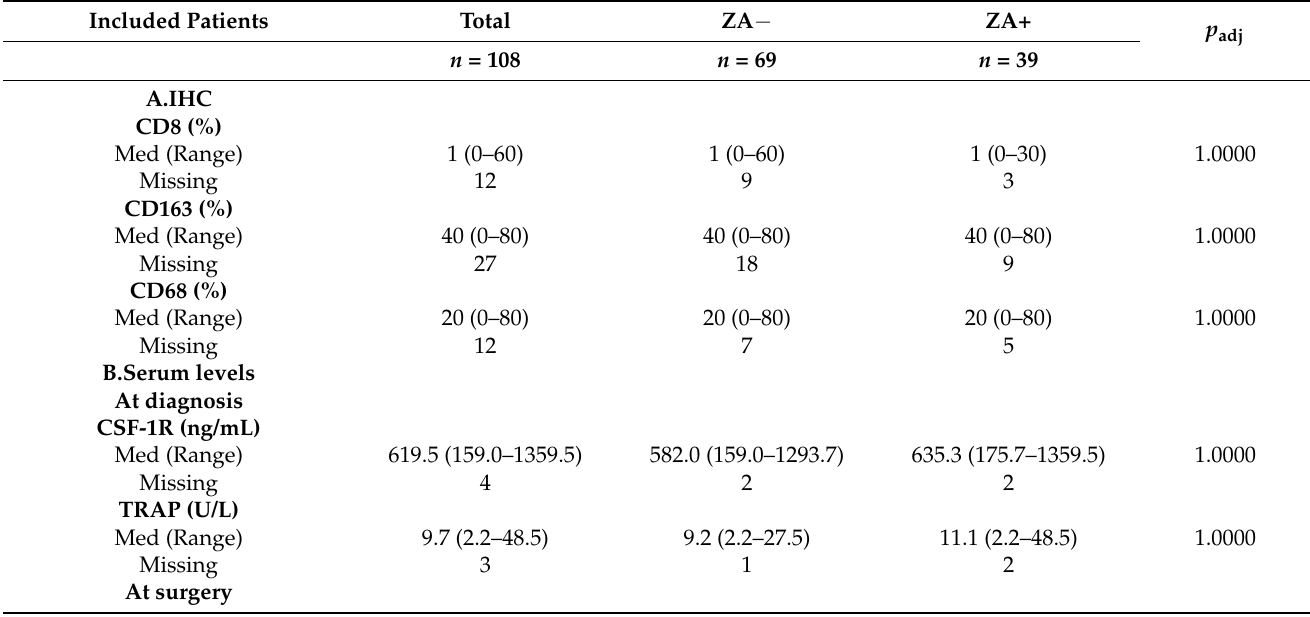
Table 2. A: Immunohistochemical analysis of macrophage, osteoclast and T-lymphocyte markers; B. serum levels of the OS2006 patients ( n = 108). Bonferroni’s adjustments were made to account for multiple testing. Included